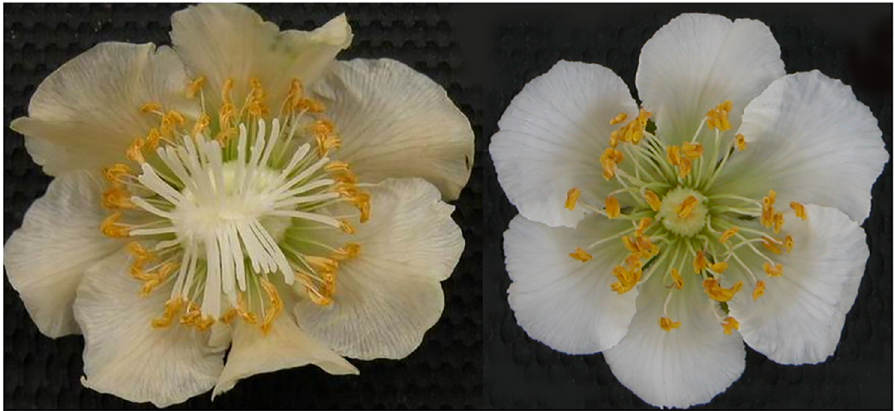
Fig 5. Morphological differences in the floral organs of female and male kiwifruit